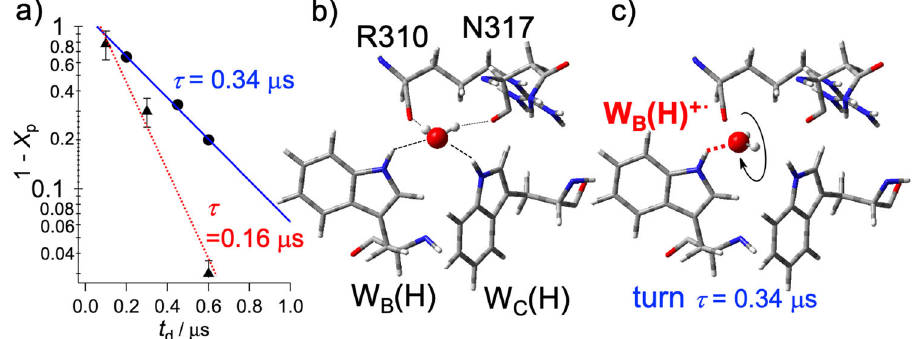
Fig. 5 Reorientation dynamics of the captured water after the secondary charge-separation. a Solvation dynamics obtained by the decay of 1 − X p in WT XlCry -DASH ( (cid:129) ) and in W342F ( ▴ ) at 120 K. b X-ray structure-based water conformation con fi ned by W − C = O groups of the backbone B (H), W C (H), and at R310 and the N317 residue of Synechocystis sp . PCC6803 cryptochrome DASH. c Water orientation change by the rehydration (red dotted line) to the cationic charge of W B (H) + (cid:129) after the secondary CS. The weakened hydrogen bonding between the water and W C (H) hinders the ternary CS by this trapping, indicating the importance of thermal water fl uctuations for the terminal CS resulting in W C (H) + (cid:129) at physiological